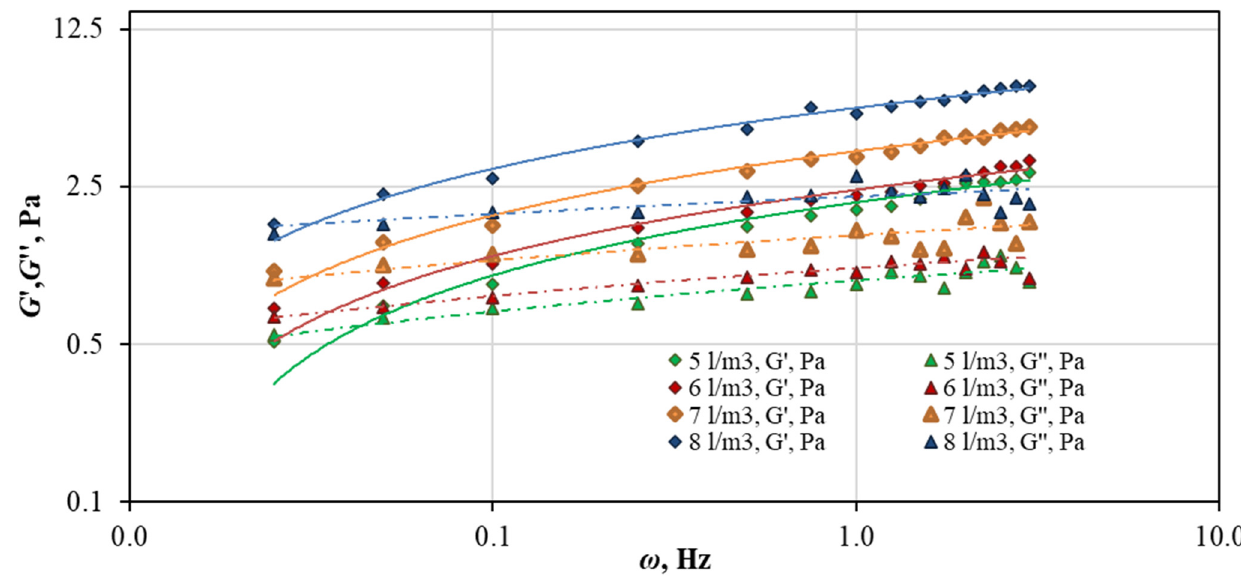
Figure 4. Frequency dependencies of G ′ and G ″ of liquid based on synthetic polymer.